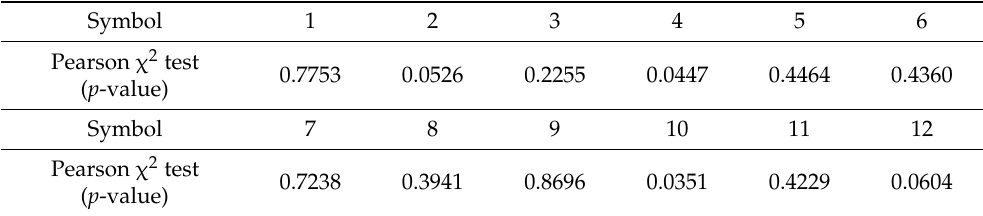
Table 1. Pearson’s test for the age of